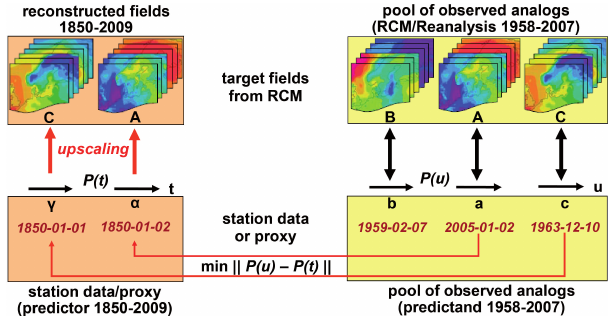
Fig. 1. Scheme for the Analog-Method used as upscaling tool. Any day a, b, c, etc. of P(u) is linked to its related fields A, B, C, etc. taken from RCM/Reanalysis (predictand, analogs). The fields of a historical day γ , α , etc. from P(t) is found by Eq. (1) to be most similar to c, a, etc. in P(u) forming the analog-pool. Hence, it is assumed that the fields of γ , α , etc. are then very similar to the fields C, A, etc.